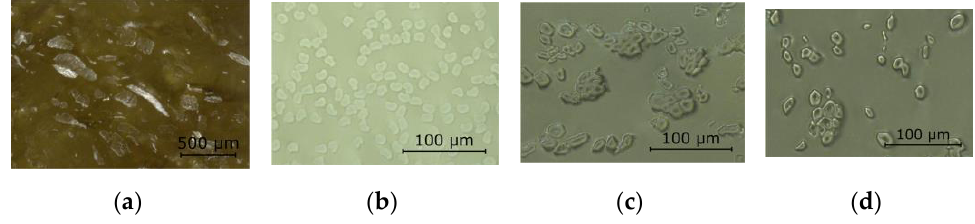
Figure 3. Microsections of some dry fiber bundles embedded in casting resin. ( a ) Hemp; ( b ) viscose; ( c ) flax tape; ( d ) flax yarn.